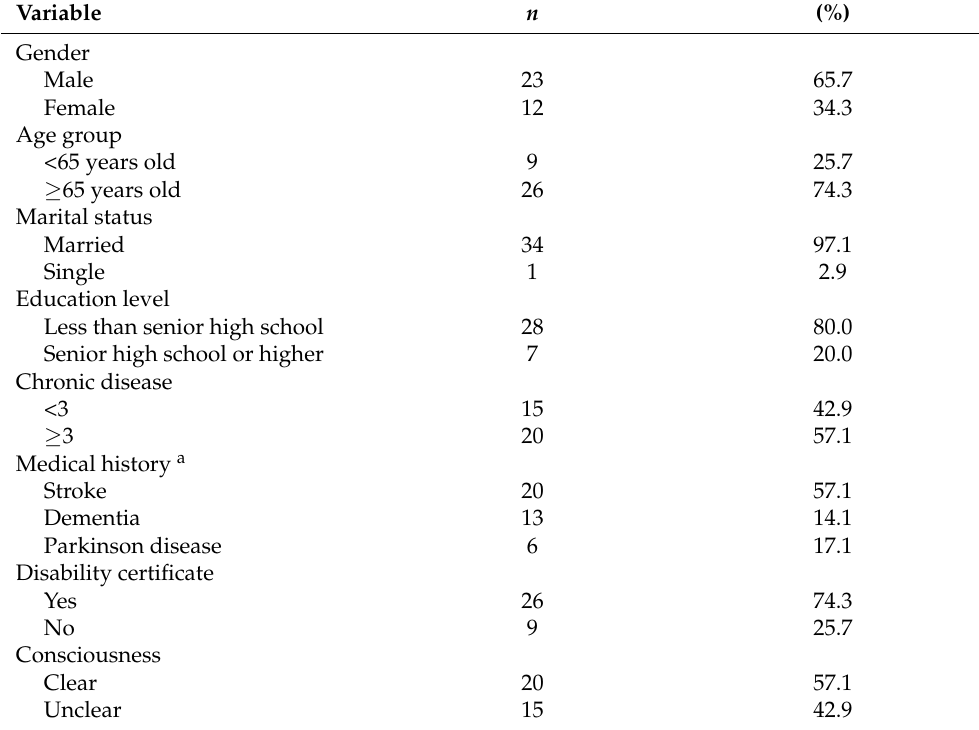
Table 1. Characteristics of